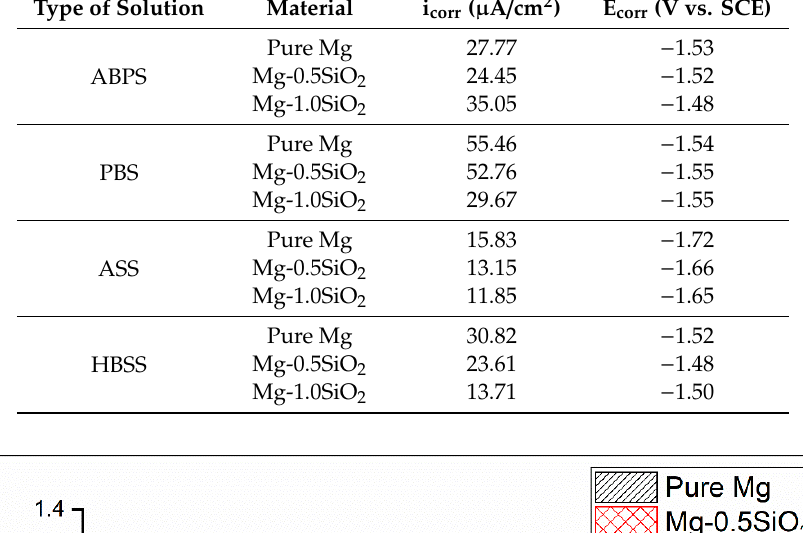
Table3. Corrosioncurrentdensity(i corr )andpotential(E corr )ofMg-SiO 2 insimulatedbodyfluids(SBFs).